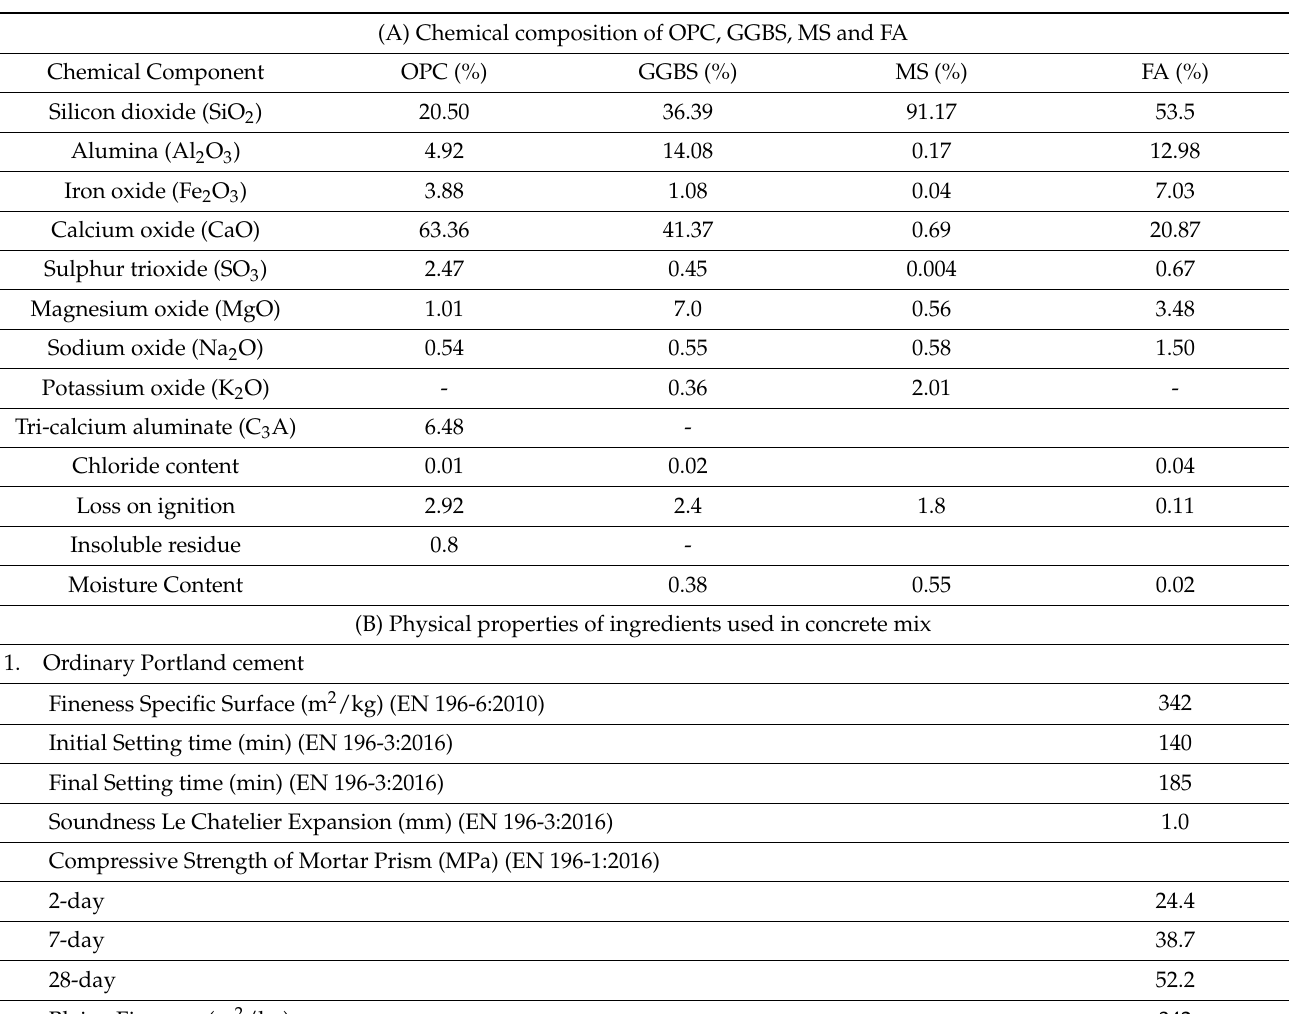
Table 4. Chemical composition and physical properties of ingredients in concrete mix. (A) Chemical composition of OPC, GGBS, MS and